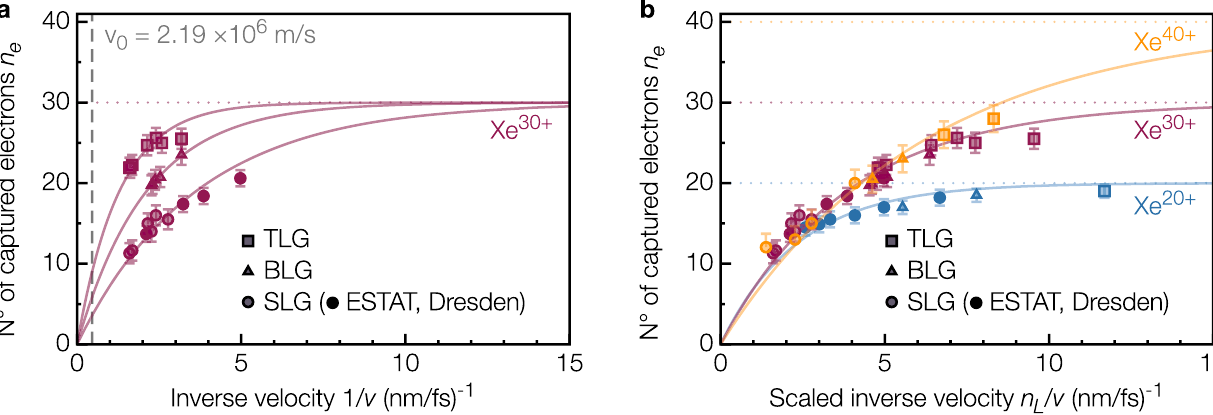
Fig. 2 Charge exchange of Xe 30 + and single-, bi- and trilayer graphene. In a , the number of captured electrons is given in dependence of the inverse projectile velocity. Exponential fi ts are added according to Eq. (1). To take into account a longer interaction zone due to the increasing number of material layers n L in comparison to single-layer graphene (SLG, circles), bilayer graphene (BLG, triangles) and trilayer graphene (TLG, squares) data points are shifted to v /2 and v /3 in b , respectively. The resulting universal charge exchange behaviour is presented in b for Xe 30 + (red) as well as for Xe 20 + (blue) and Xe 40 + (orange). Error bars were calculated taking into account the in fl uence of limitations in the ion beam setup on the evaluation of mean exit charge states and the mean distribution of exit charge states in spectra obtained using an electrostatic analyser (ESTAT),